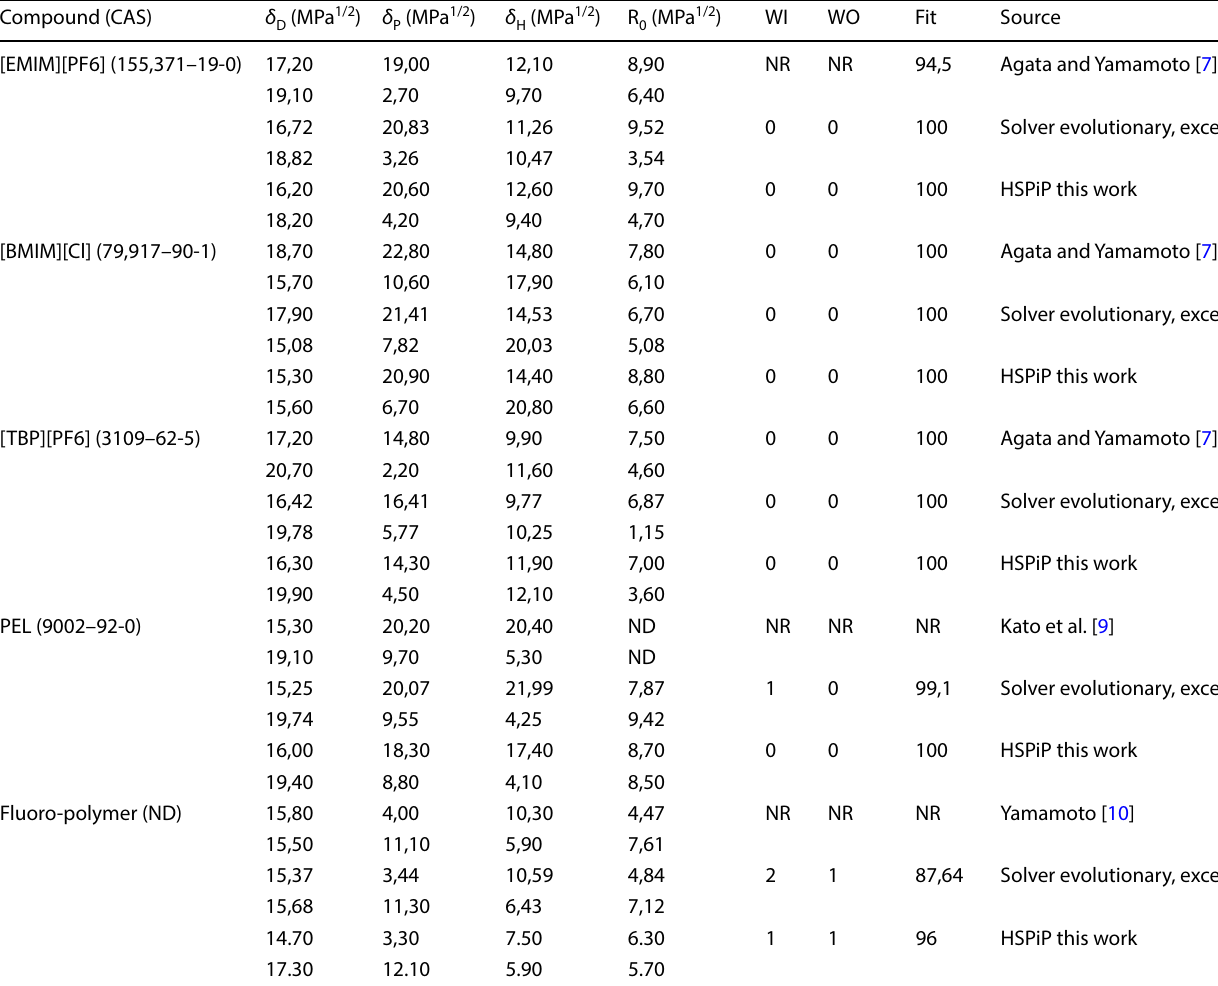
Table 1 Results obtained for double Hansen’s sphere calculation with evolutionary algorithm of Microsoft Excel, HSPiP software and litera-